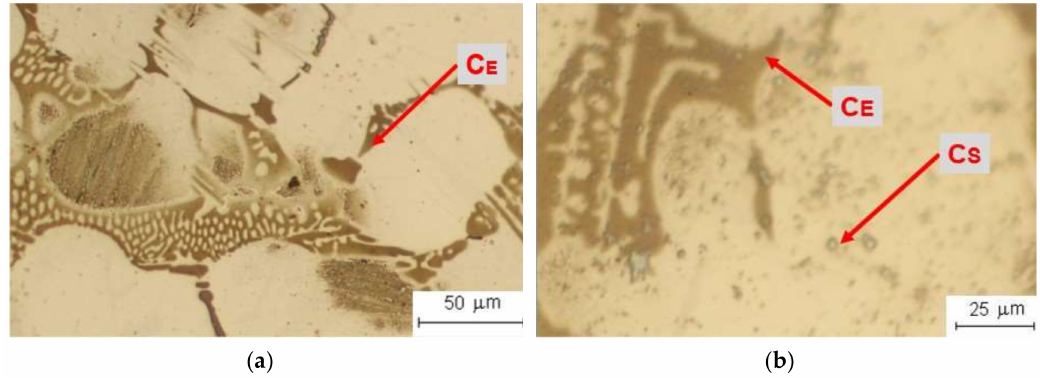
Figure 7. Murakami reagent at room temperature: ( a ) general view at 200 × ; ( b ) detail at 500 ×